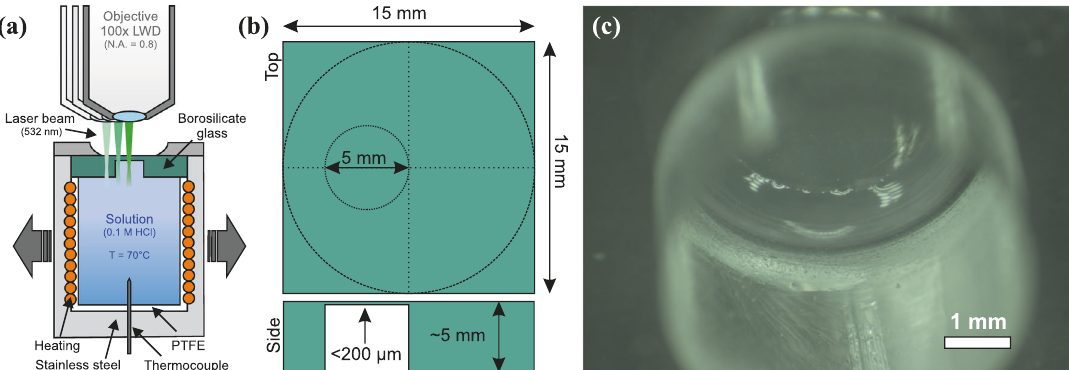
Fig. 1 Experimental setup. a Schematic of fl uid cell. For illustration, relative movement between objective and fl uid cell is presented here, while in reality the objective is fi xed to the microscope, and the XYZ stage, on which the fl uid cell is mounted, is the only moving part. b Schematic of glass lid with dimensions. c Micrograph taken from the bottom of the glass cuboid into the blind